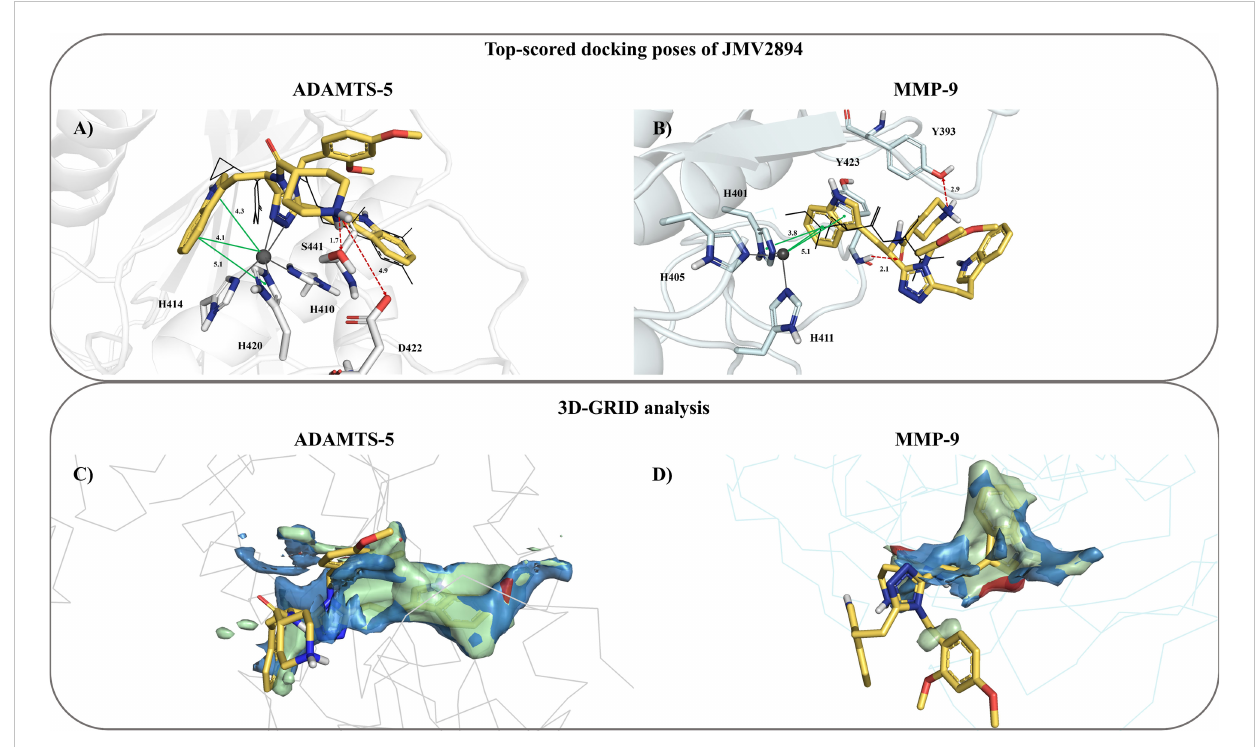
FIGURE 8 Top-scored docking poses of JMV2894 towards (A) ADAMTS-5 (PDB entry: 6YJM) and (B) MMP-9 (PDB entry: 1GKC), respectively. Green and red arrows indicate p − p or p -cationinteractions and hydrogen bonds, respectively. ADAMTS-5 and MMP-9 binding site residues arerendered in grey and cyan sticks, respectively. For the sake of completeness, all molecularinteractions observed in docking simulations are shown. GRID MIFs generated on the basis of (C) ADAMTS-5 and (D) MMP-9 crystal structures. The hydrophobic, HB acceptor, and HB donorinteractions are displayed in green, red, and blue surface, respectively. A cut-off value of – 1.0kcal/mol, − 4.5 kcal/mol, and − 3.0 kcal/mol is set for CRY-, N1-, and O-GRID probes, respectively. The top-scored docking poses of JMV2894 are reported as yellow sticks, while ADAMTS-5 andMMP-9 binding sites are rendered in grey and cyan ribbon,